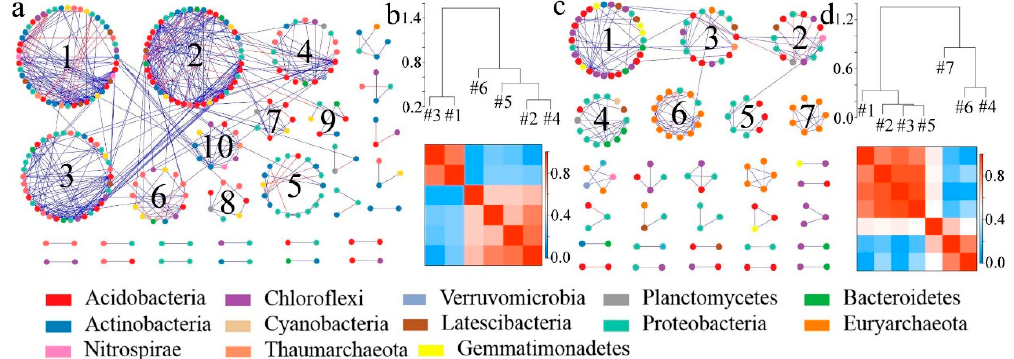
Figure 5. Soil bacterial molecular ecological networks and modular eigengene hierarchy structure in DL and PF. ( a ) Soil bacterial molecular ecological network in the DL; ( b ) soil bacterial modular eigengene hierarchy structure in the DL; ( c ) soil bacterial molecular ecological network in the PF; ( d ) soil bacterial modular eigengene hierarchy structure in the PF. Note: The connection lines represent the interactions between communities on the phylum level. The blue and red colors indicate positive and negative, respectively (the use of colors remains the same in the following sections).